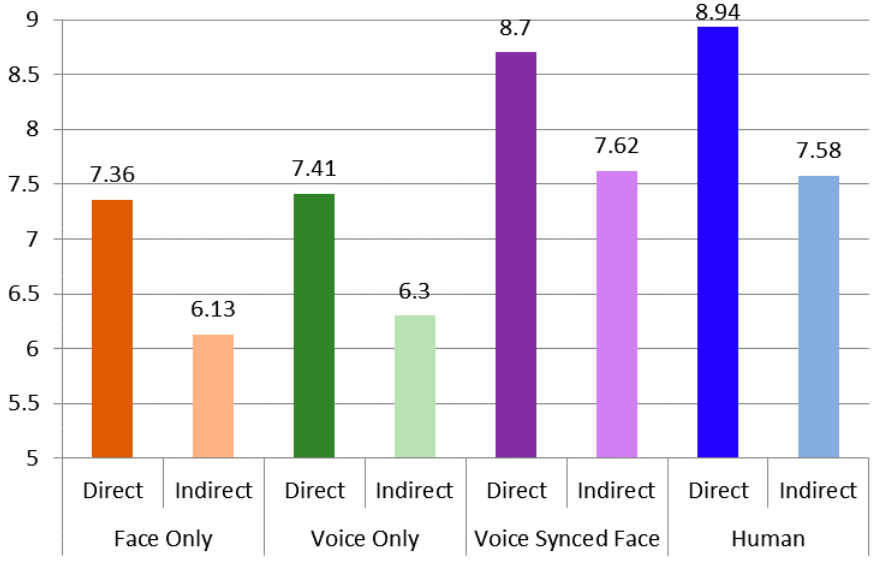
Figure 6. Mean valence toward the presenter for each evaluation type. (direct, indirect) for each presenter type (face only, voice only, voice synced face, human) ( n = 80).